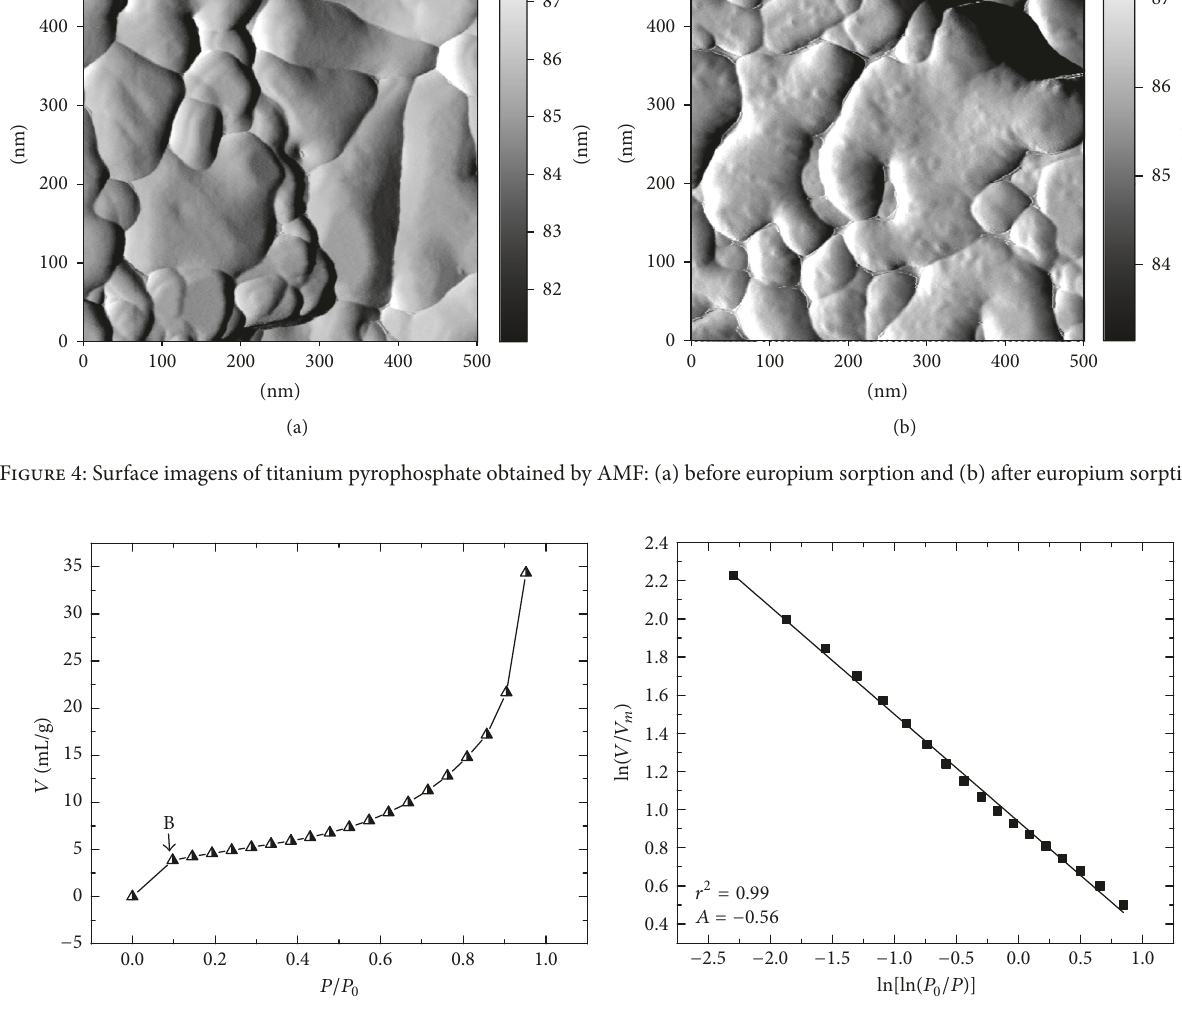
ℎ = 8.35 × 10 −4 mg g −1 min −1 , 𝑞